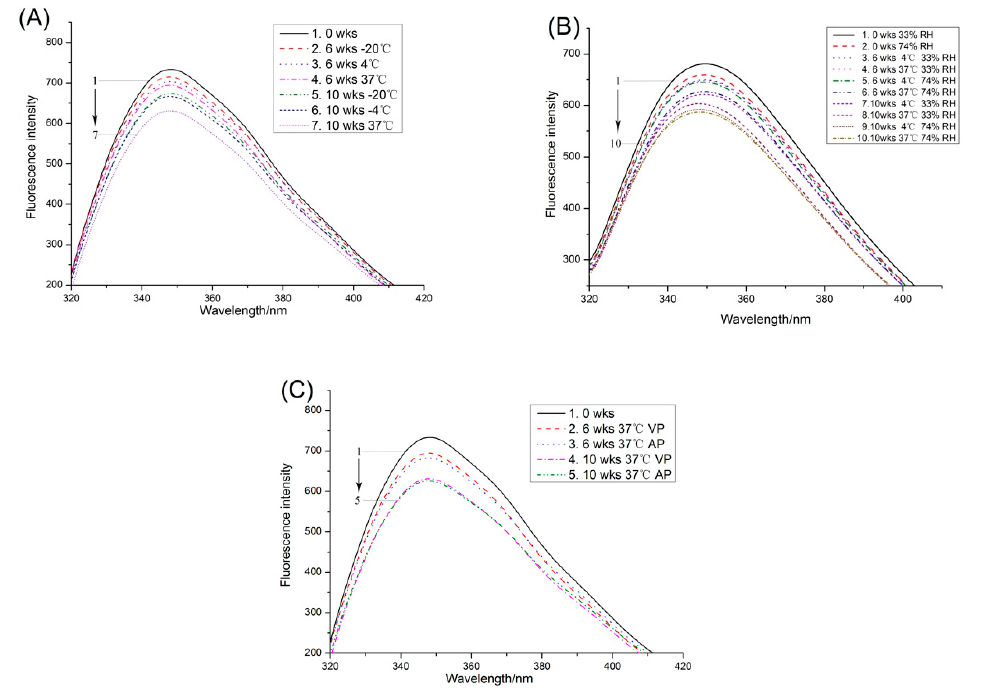
Figure 2. Changes in the intrinsic fluorescence spectra of PPI stored at different temperature ( A ), relative humidity ( B ) and packaging methods ( C ).